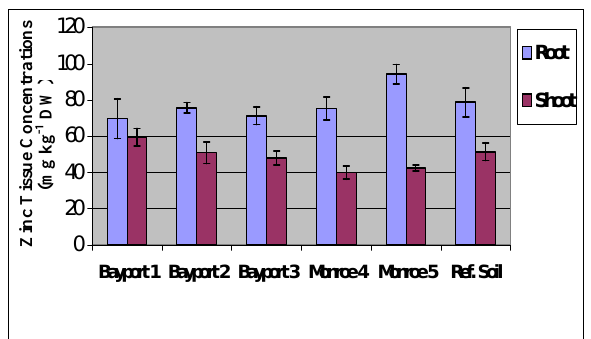
Figure 2: Mean concentrations of zinc in Triticum aestivum (mean and standard error; N=4). No significant differences observed when compared to plants grown in the reference soil according to Dunnet test. Zinc accumulation in the root ranged from 69.56 ± 11.01mg kg -1 DW in T. aestivum plants grown on Bayport 1 DM to 94.01 ± 5.34 mg kg -1 DW in plants grown on Monroe 5 DM (Figure 2). Zn accumulation